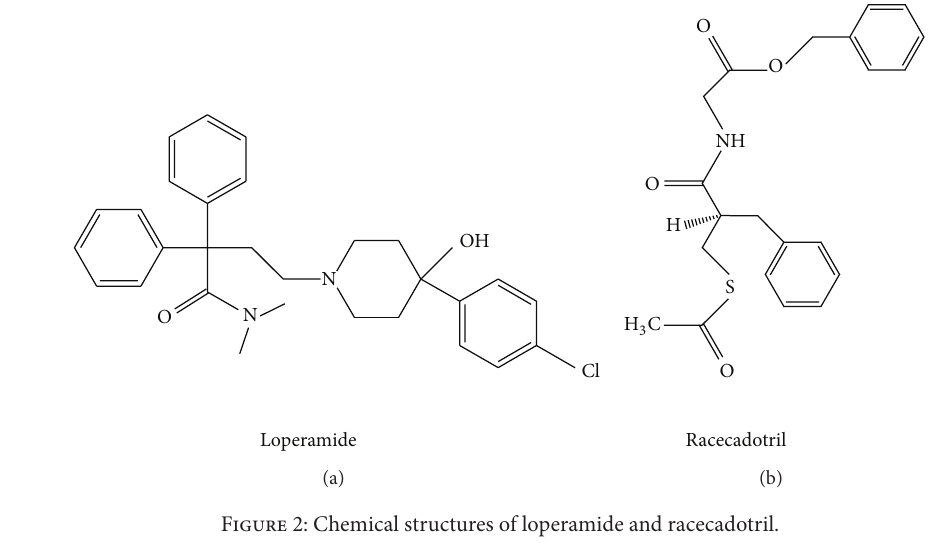
Figure 2: Chemical structures of loperamide and racecadotril.